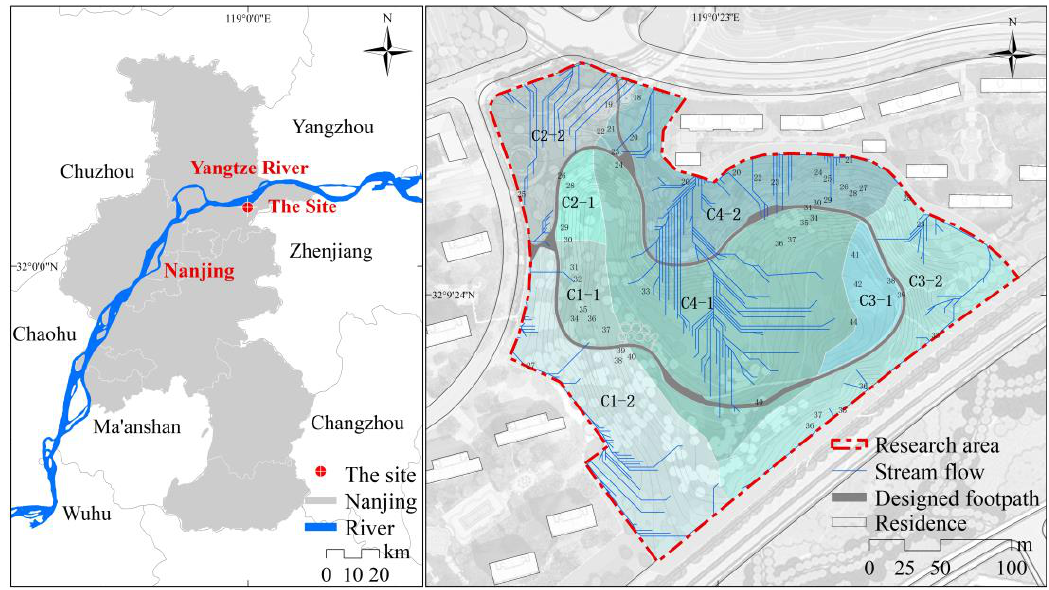
Figure 2. The basic situation of Guanyao Mountain Park. Table 1. Characteristics of the sub-catchments in Guanyao Mountain